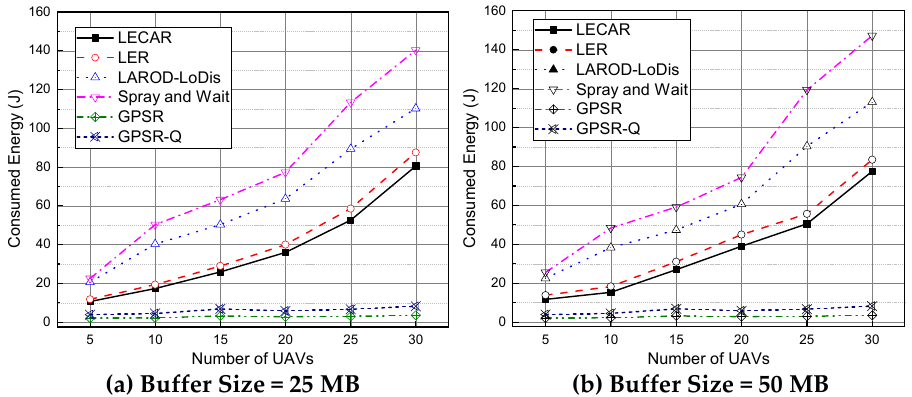
Figure 17. Performance comparison of the considered routing protocols regarding consumed energy consumption when the buffer size is ( a ) 25 MB and ( b ) 50 MB.